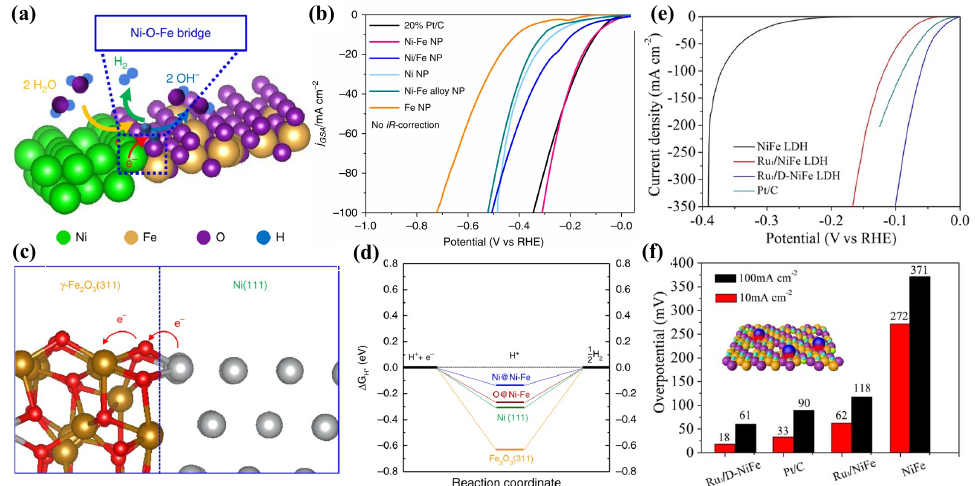
Figure 10. ( a ) Schematic representation. ( b ) HER-LSV curves of the Ni-Fe Janus nanoparticles, theoretical comprehension. ( c ) Ni-Fe heterojunction interface structure that has been optimized. ( d ) Standard free energy diagram of the HER process on the surfaces of Fe 2 O 3 (311) and Ni(111) in the Ni-Fe heterojunction. ( e ) HER polarization curves, reprinted with permission from Ref. [69], and ( f ) overpotentials at typical current densities of various LDHs, reprinted with permission from Ref. [70]. While NiFe-layered double hydroxide (NiFe-LDH) offers great potential as a bifunc- tional electrocatalyst for simultaneously catalyzing the HER and OER in alkaline solu- tions, the hydrogen binding property on the Fe 3+ center is rather sluggish, resulting in a high kinetic energy barrier for the Volmer step and sluggish HER kinetics under alkaline conditions. To break through this barrier, atomic-level control of active sites is required.